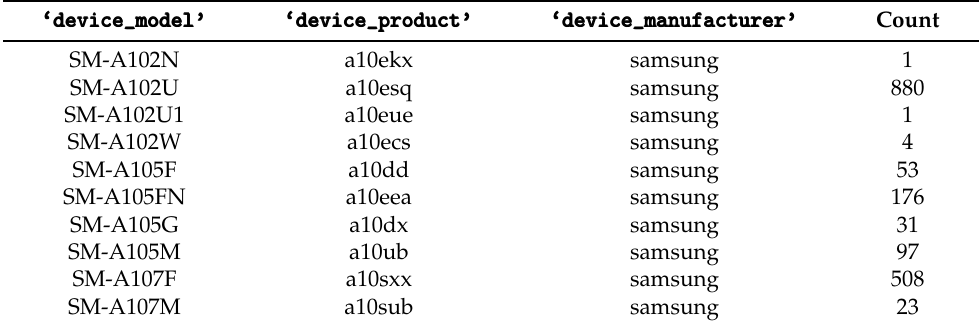
Table 3. Collected device information for the Samsung Galaxy A10 Android phone, as well as, the count of corresponding phones in the NoiseCapture database.